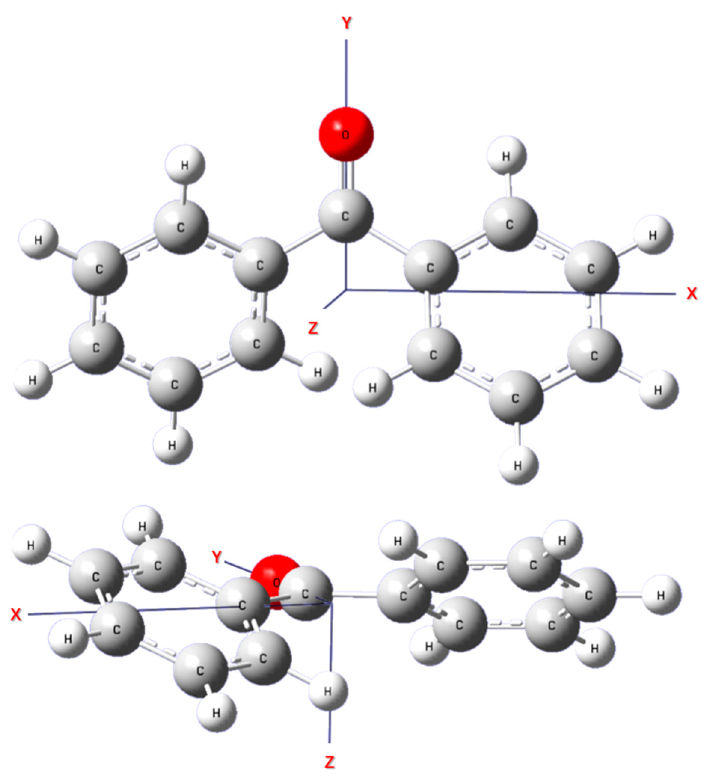
Figure 5. Optimized global minimum geometries for benzophenone on the MP2 / cc-pVDZ theory level. Table 1. The computational rotational constant, moment of inertia, planar moment of inertia, dipole moment and asymmetric parameter of benzophenone.